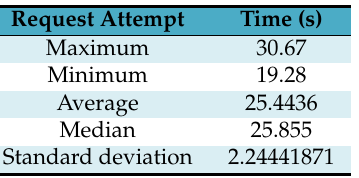
Table 8. Most prominent figures obtained from CDT discovery measures.